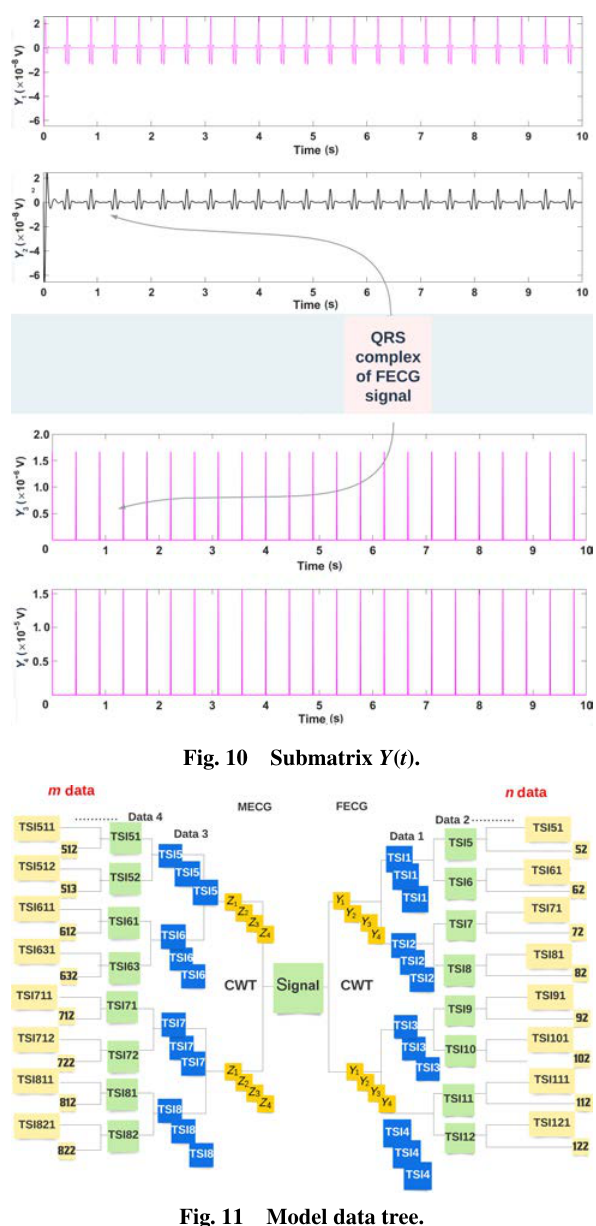
Fig. 11 Model data